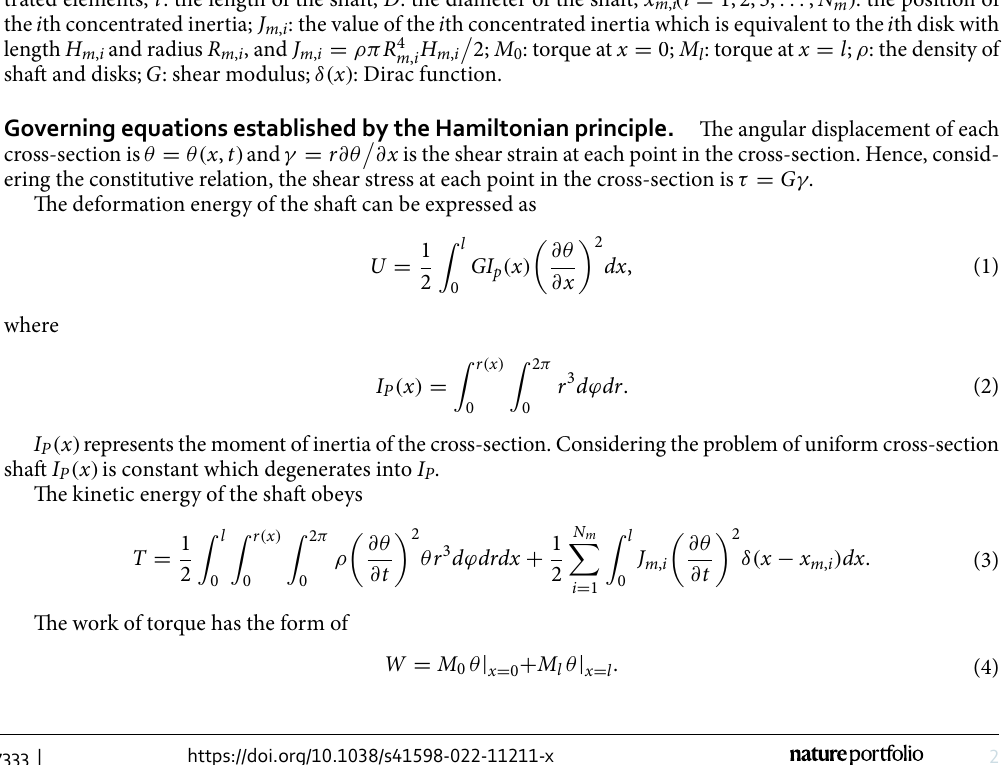
single rotary inertia or torsional spring. In 1988, Rao 18 gave the exact expressions for the torsional frequencies and mode shapes of the generally constrained shafts and piping with two disks. Reference 19 studied the torsional vibration problem of a beam containing lumped elements under cantilever boundary conditions and fixed boundary conditions. As for the “exact” solutions of the torsional vibration of uniform shafts carrying multi concentrated elements, the information concerned is rare. Only Chen 20 presented an “exact” solution for free torsional vibration of a uniform circular shaft carrying multiple concentrated elements adopting the numerical assembly method (NAM). But NAM 21–23 does not give the “exact” expression of mode shapes, and the method